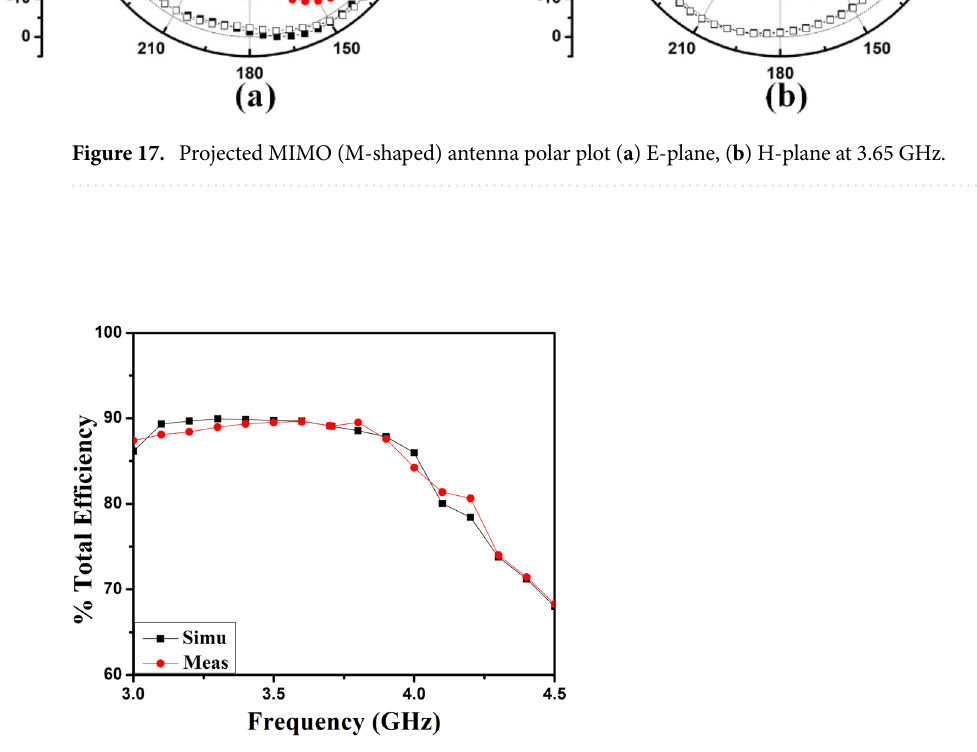
Figure 18. Proposed two members MIMO (M-shaped) antenna total